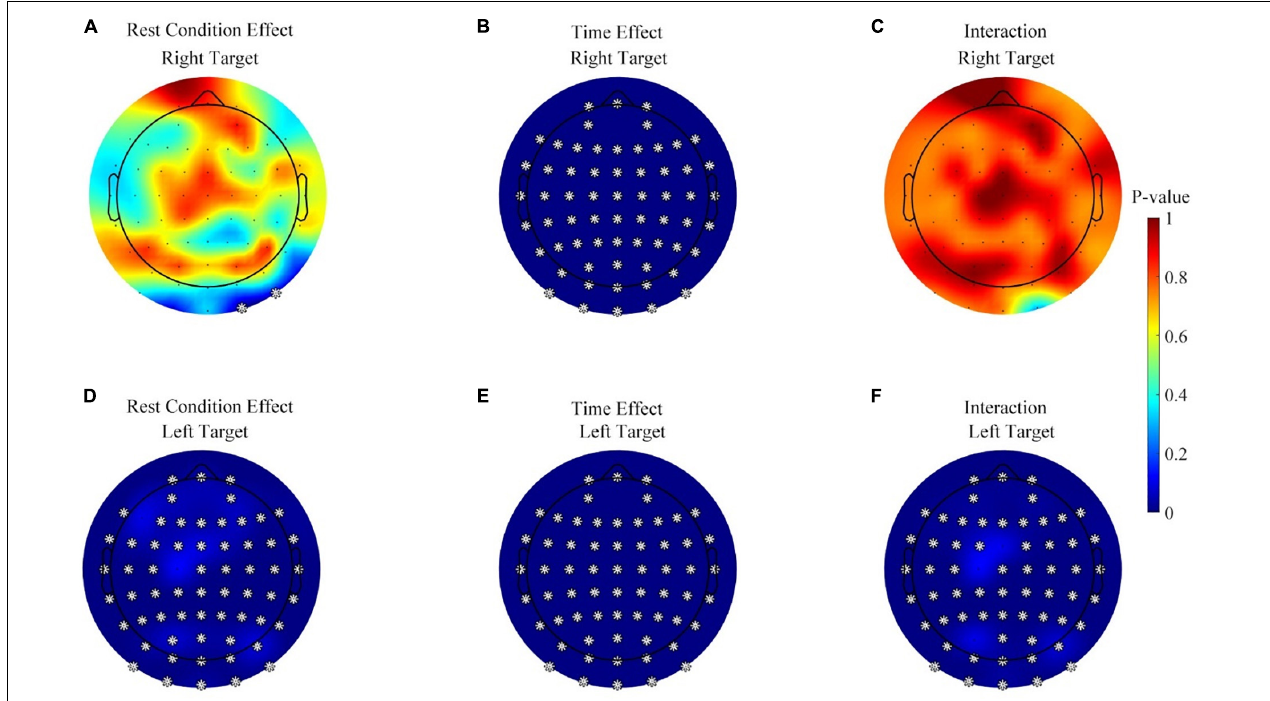
FIGURE 7 | Statistical analysis results for the effects of rest conditions, the measured time, and the interaction on alpha power in the feedback period. (A) The effect of rest conditions during the right target. (B) The effect of the measured time during the right target task. (C) The effect of the interaction during the right target task. (D–F) The effect of the rest conditions, measured time, and their interaction during the left target, respectively. * p ≤